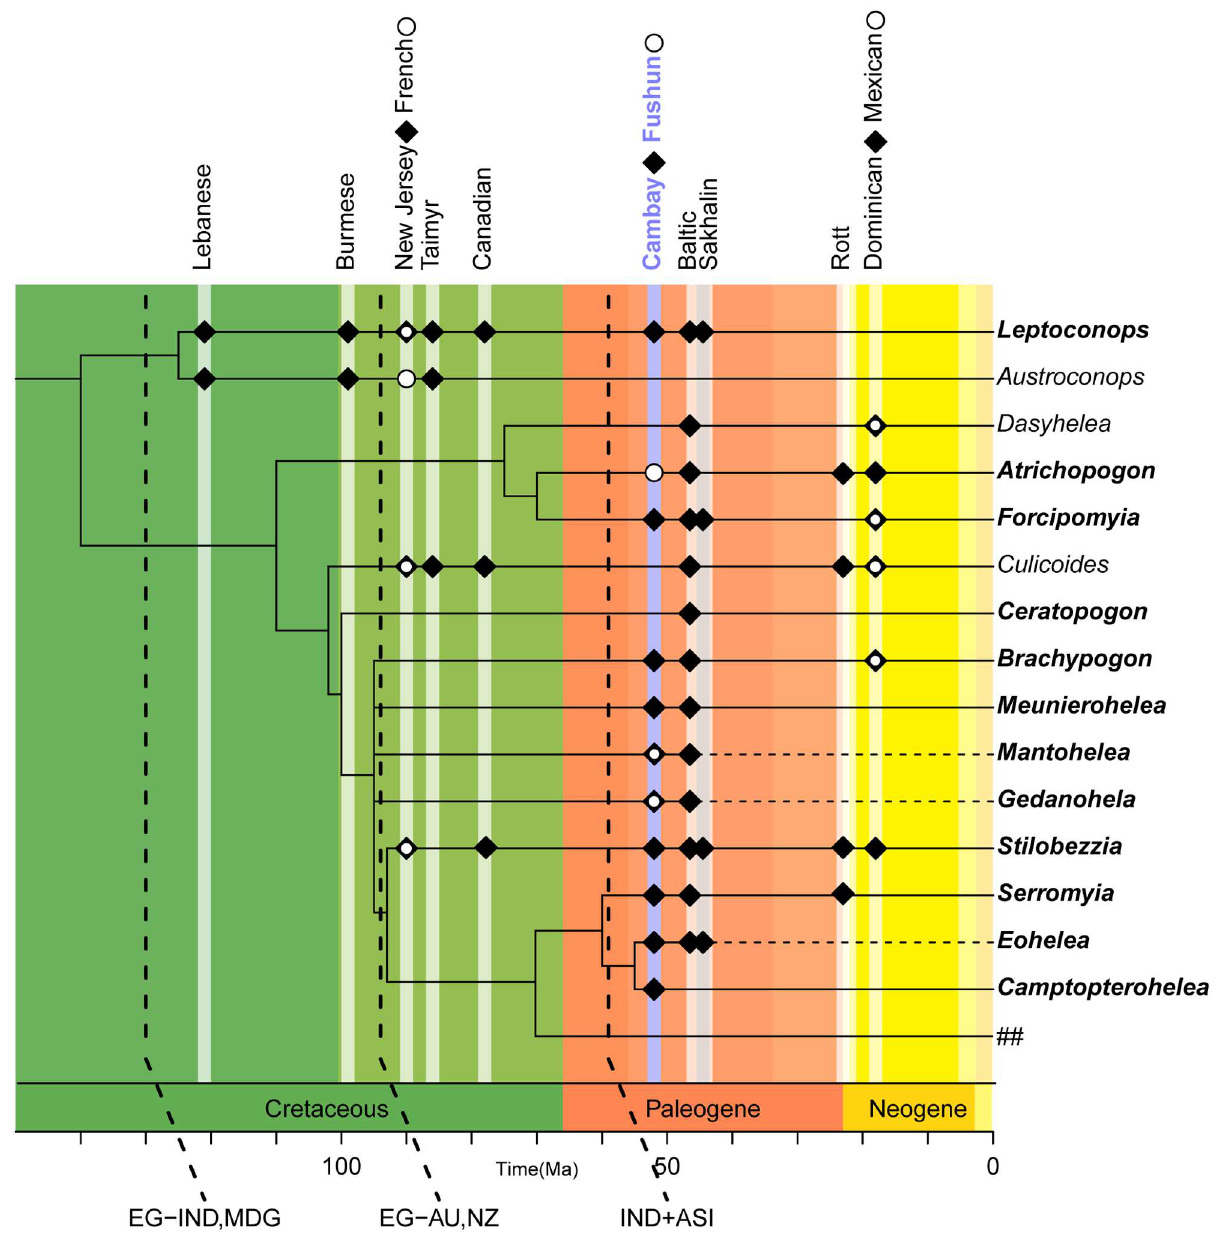
Fig 9. Relationships of select extant and fossil Ceratopogonidae genera (compiled from data after [28, 59, 60, 63]). Dashedlines in the cladogramrefer to extinct taxa, solid lines to extant taxa. ## refers to generain tribes different than